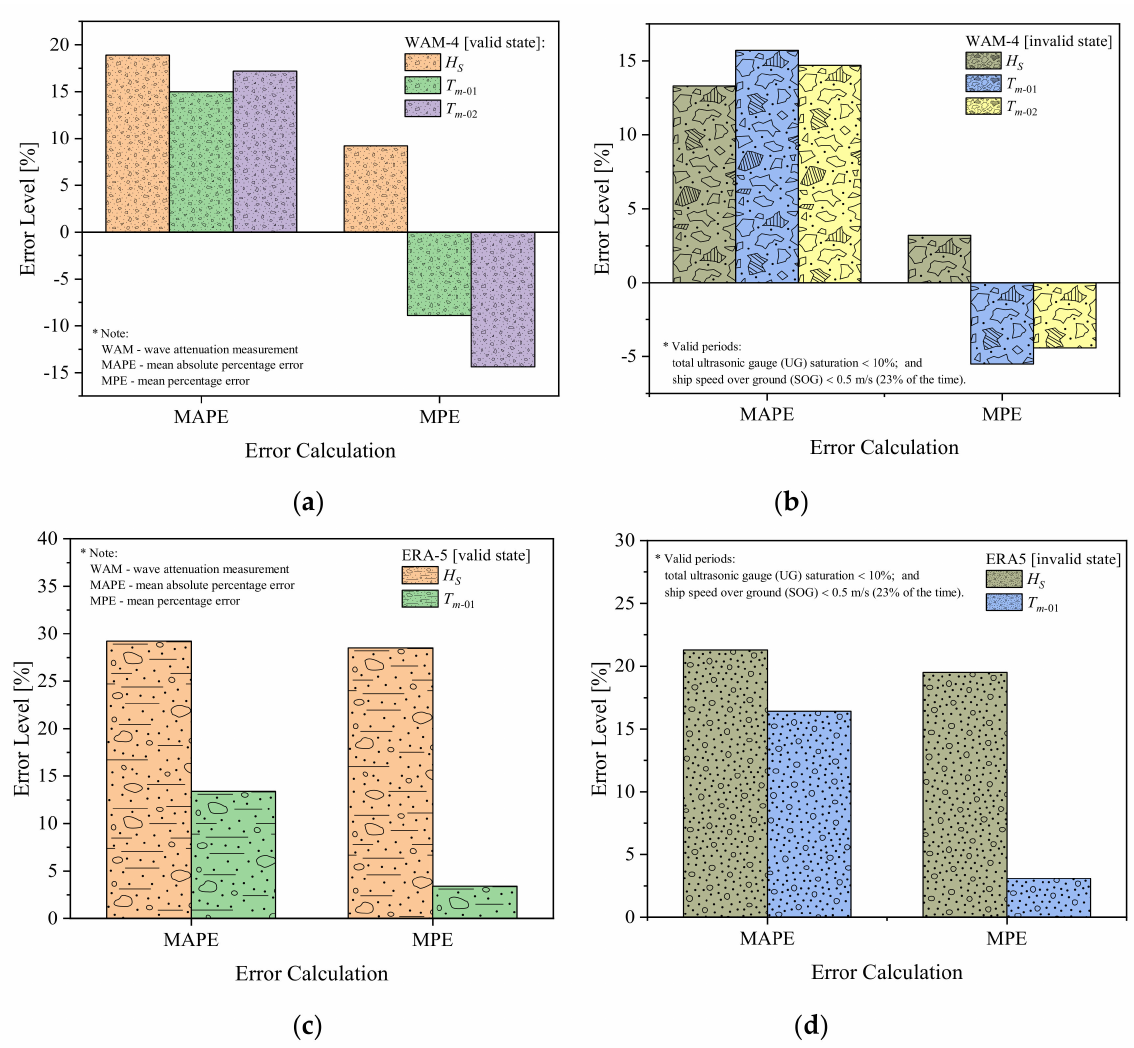
Figure 17. Comparison of the measurement data from WAM-4 ( a , b ) and ERA5 ( c , d ): the wave height ( H S ) and periods ( T m- 01 and T m- 02 ) (based on data in